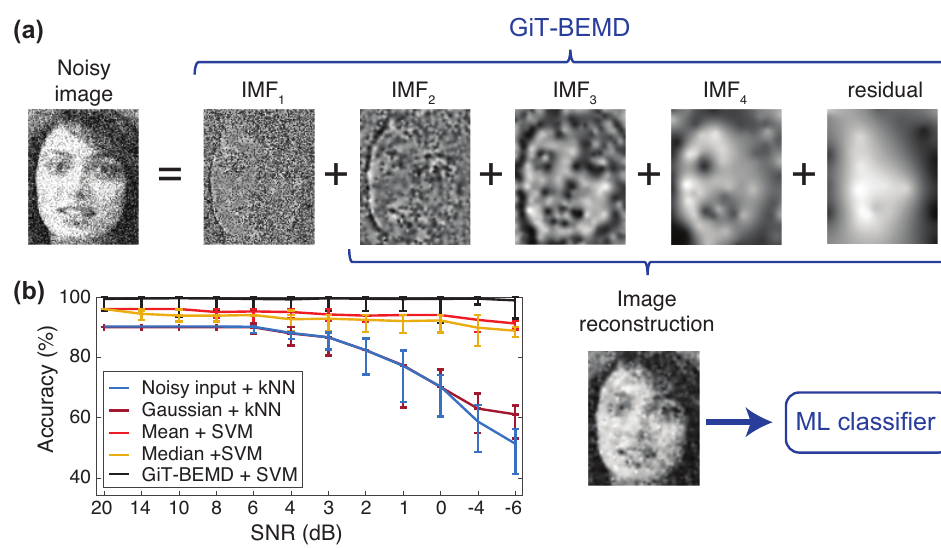
Figure 5. ( a ) The new proposed approach to eliminate the noise and improve the classification accuracy is based on the GiT-BEMD decomposition. The high frequency IMFs are discarded and the (noiseless) image is reconstructed by summing up the rest of the modes. This is the image that will feed the classifier. ( b ) Comparison of classification results using a Support Vector Machine (SVM) and K-Nearest Neighbor (kNN) classifiers applied to noisy, filtered faces (Gaussian, Mean, Median) and GiT-BEMD processed